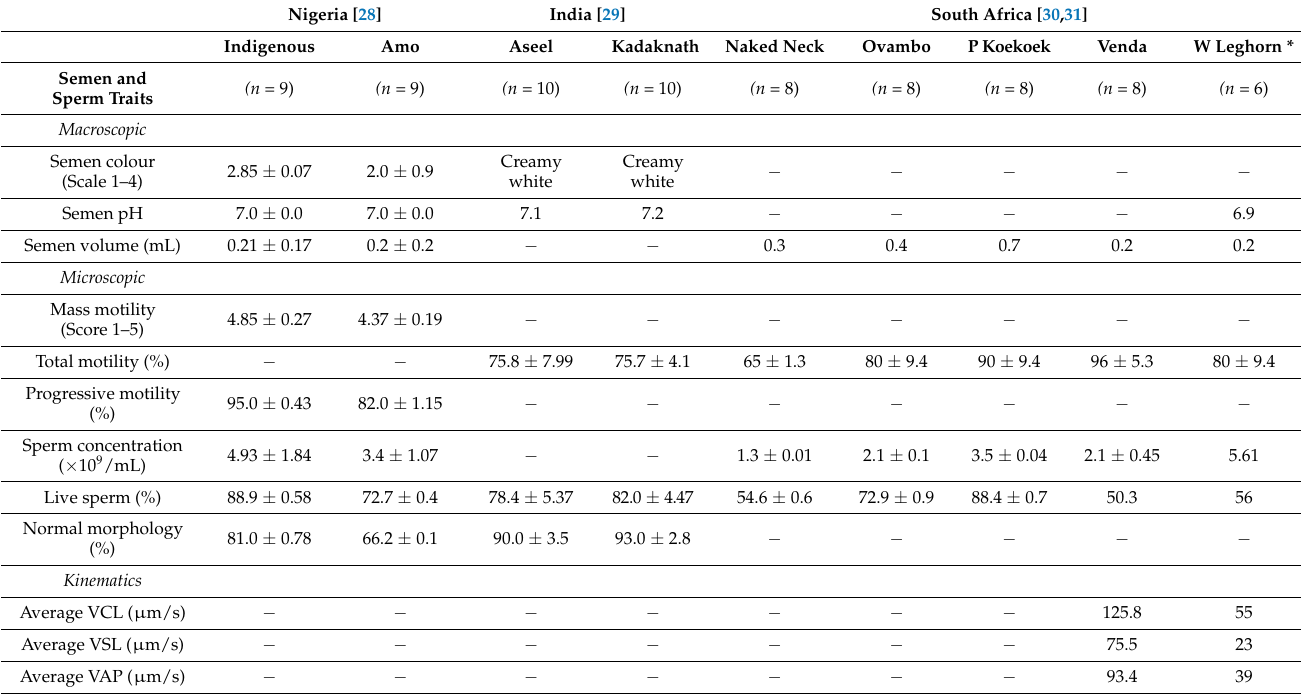
Table 3. Comparison of semen and sperm characteristics of indigenous and exotic chicken breeds in Nigeria, India, and South Africa. The data presented is focused on Africa but emphasizes that globally there seem to be great similarities between semen and sperm characteristics of indigenous compared to exotic breeds. In instances where a parameter is only presented for one breed, these values are included for future reference.